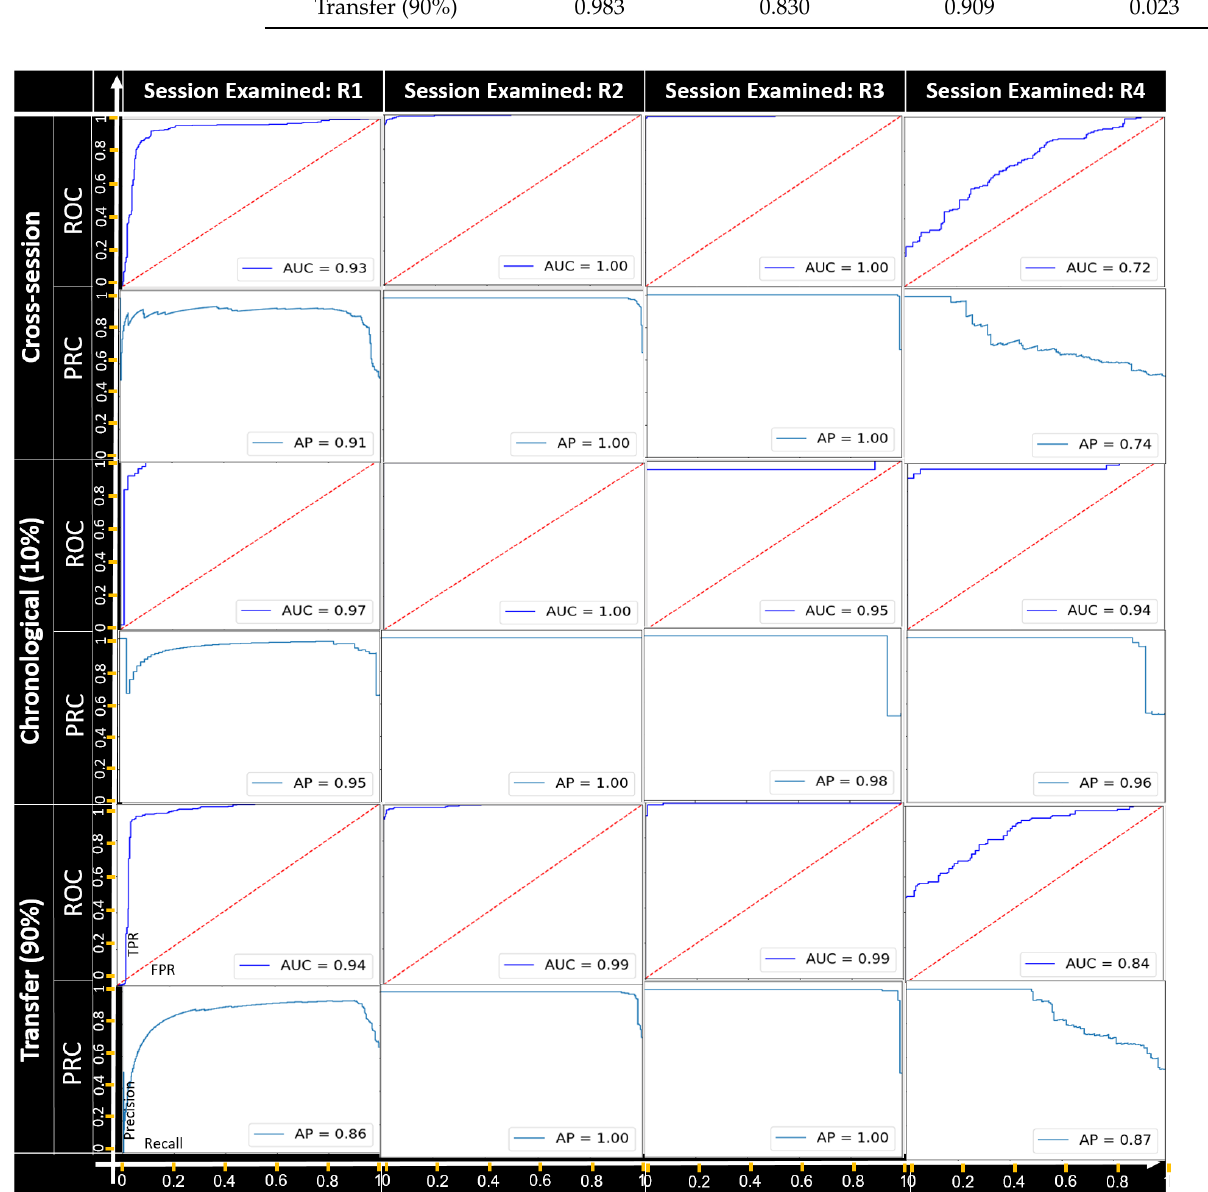
Figure 5. The ROC and PRC curves for the objectType feature-manipulation attack for each recording session